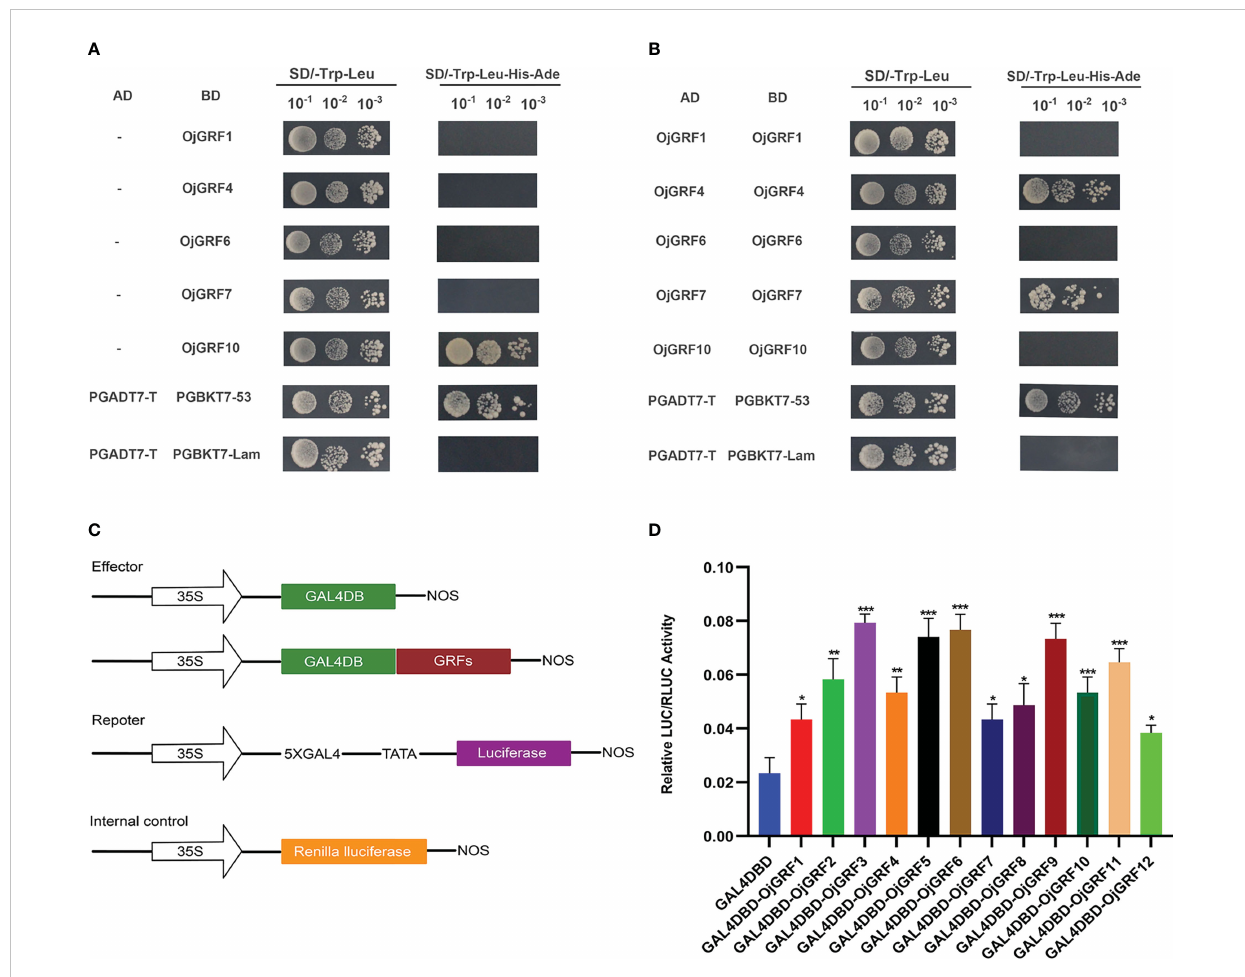
FIGURE 7 Transcriptional activity assay of GRFs . (A) Analysis of GRFs protein transcriptional self-activating activity in yeast; (B) Analysis of GRFs protein dimers in yeast; (C) The vector constructs are used in the dual-luciferase assay; (D) Dual-luciferase assay in rice protoplasts. The error bars show the standard deviations of the three independent biological replicates. Student ’ s t-test was used in this experiment; *; *p < 0.05, **p < 0.01, ***p <